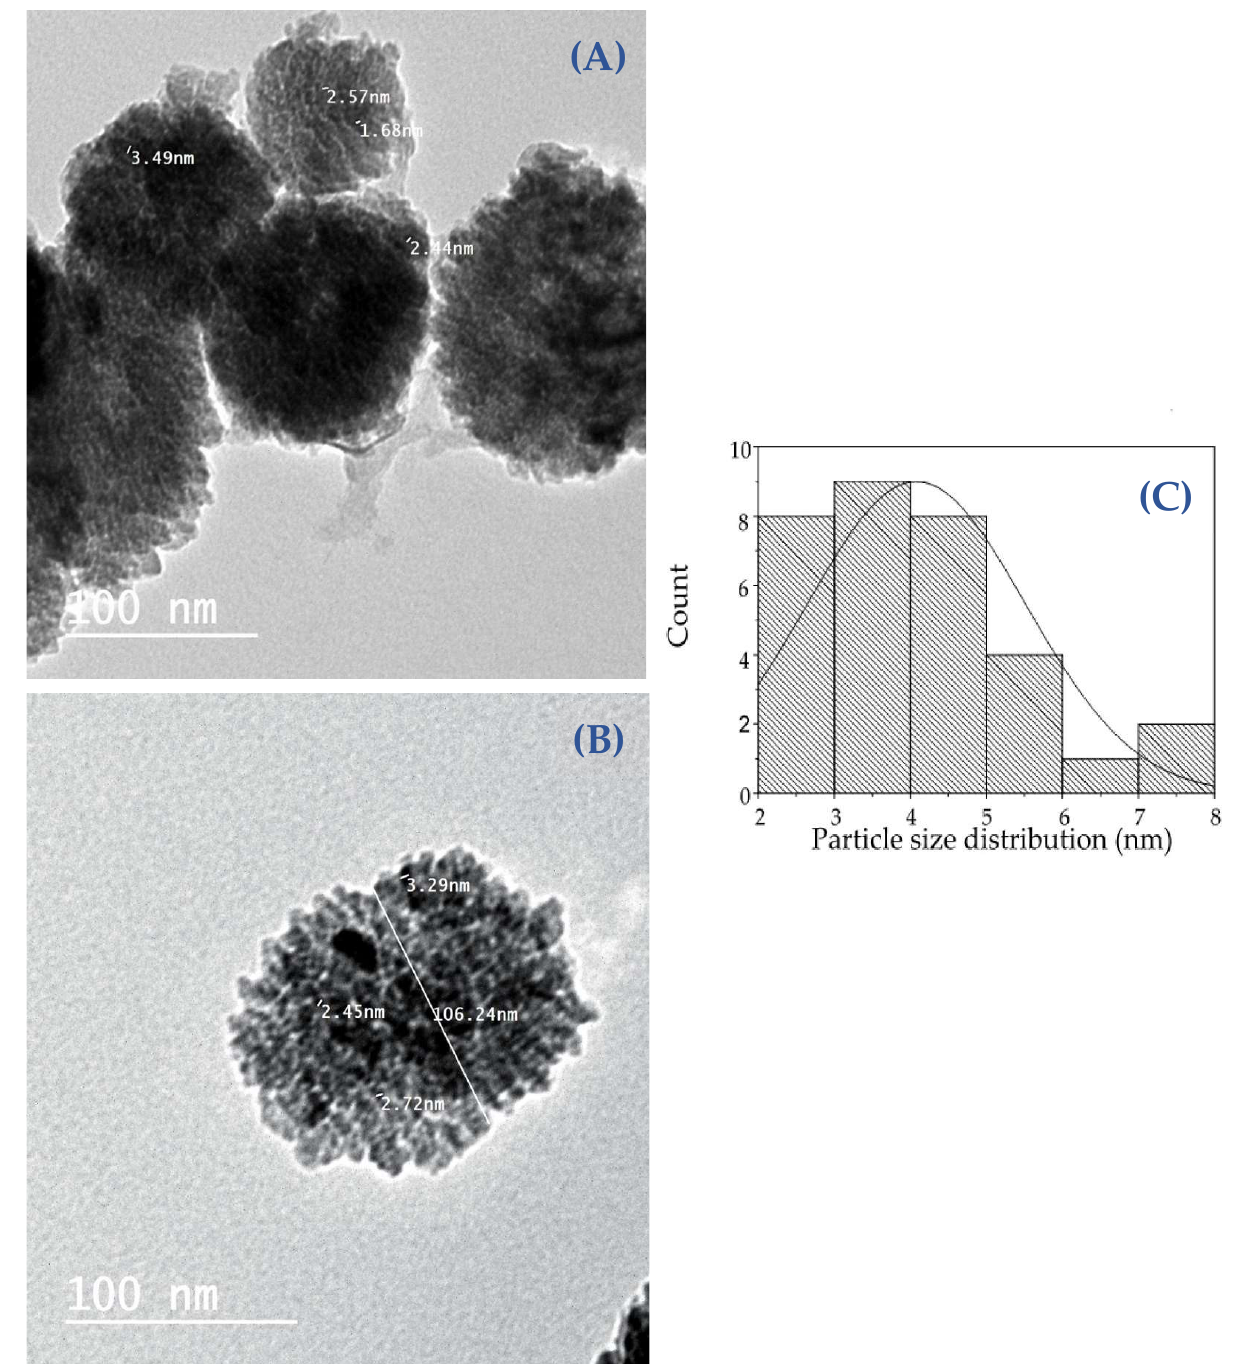
Figure 7. TEM image of green-synthesized Zno-NPs ( A , B ) and a histogram of the particle size distribution ( C ).